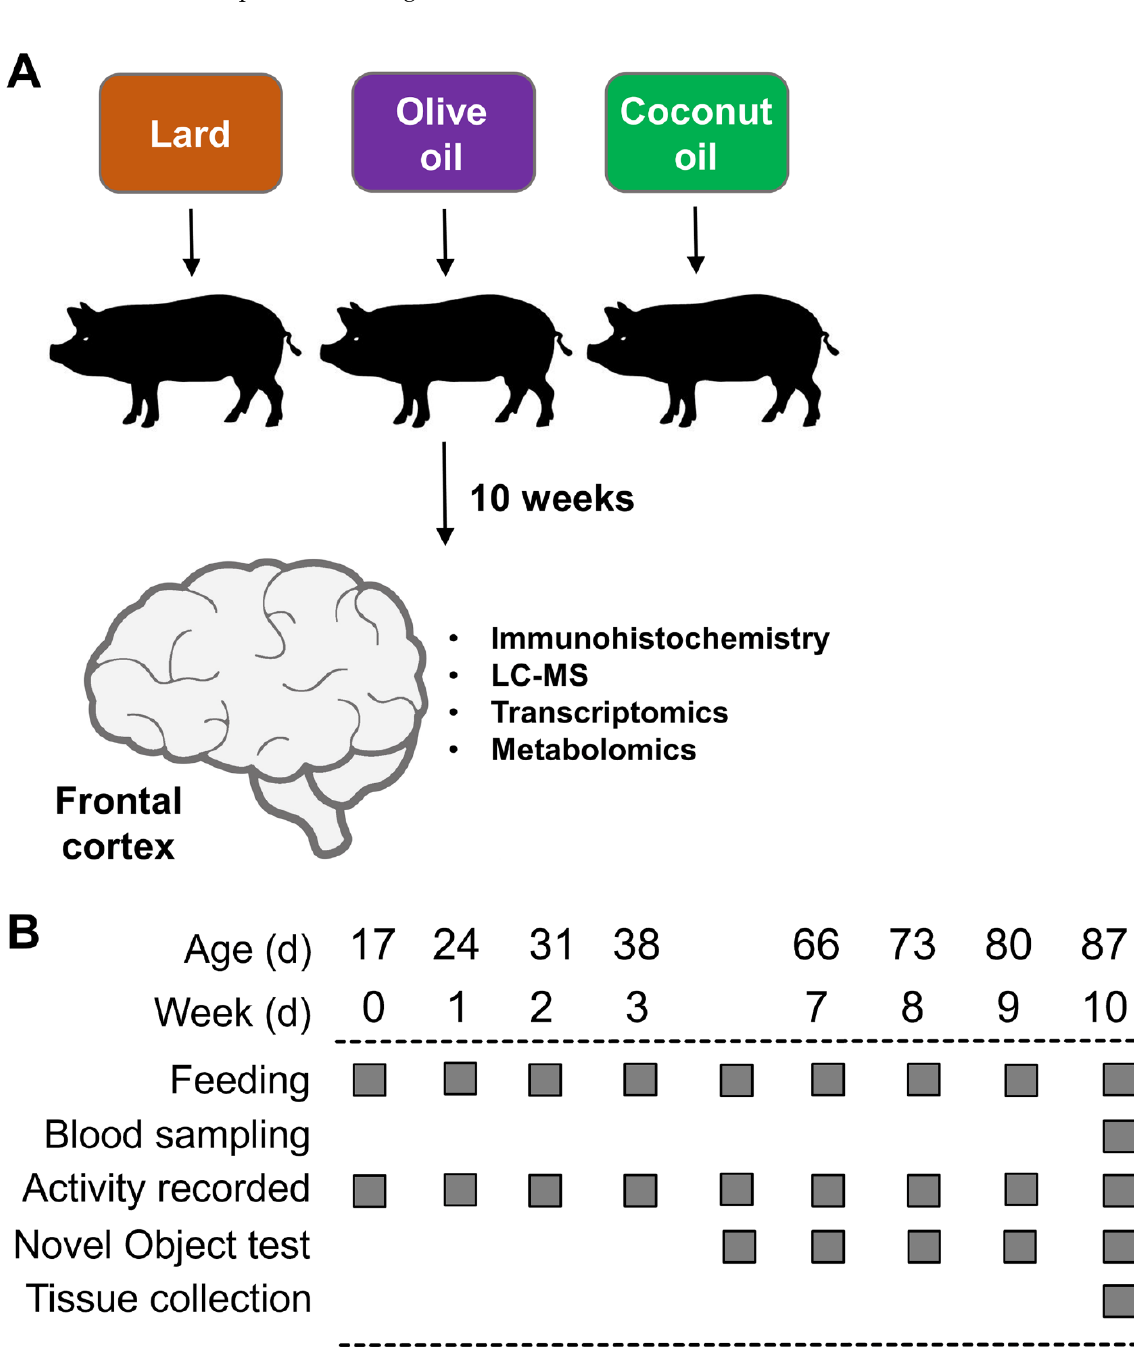
Figure 1. ( A ) Experimental design. ( B ) Timeline of activities during the 10 weeks of the study. Briefly, 19 male (M) and 11 female (F) Iberian pigs from the Iberian Pig Research Colony at California Polytechnic State University were weaned at 17 ± 3 d of age and 4.21